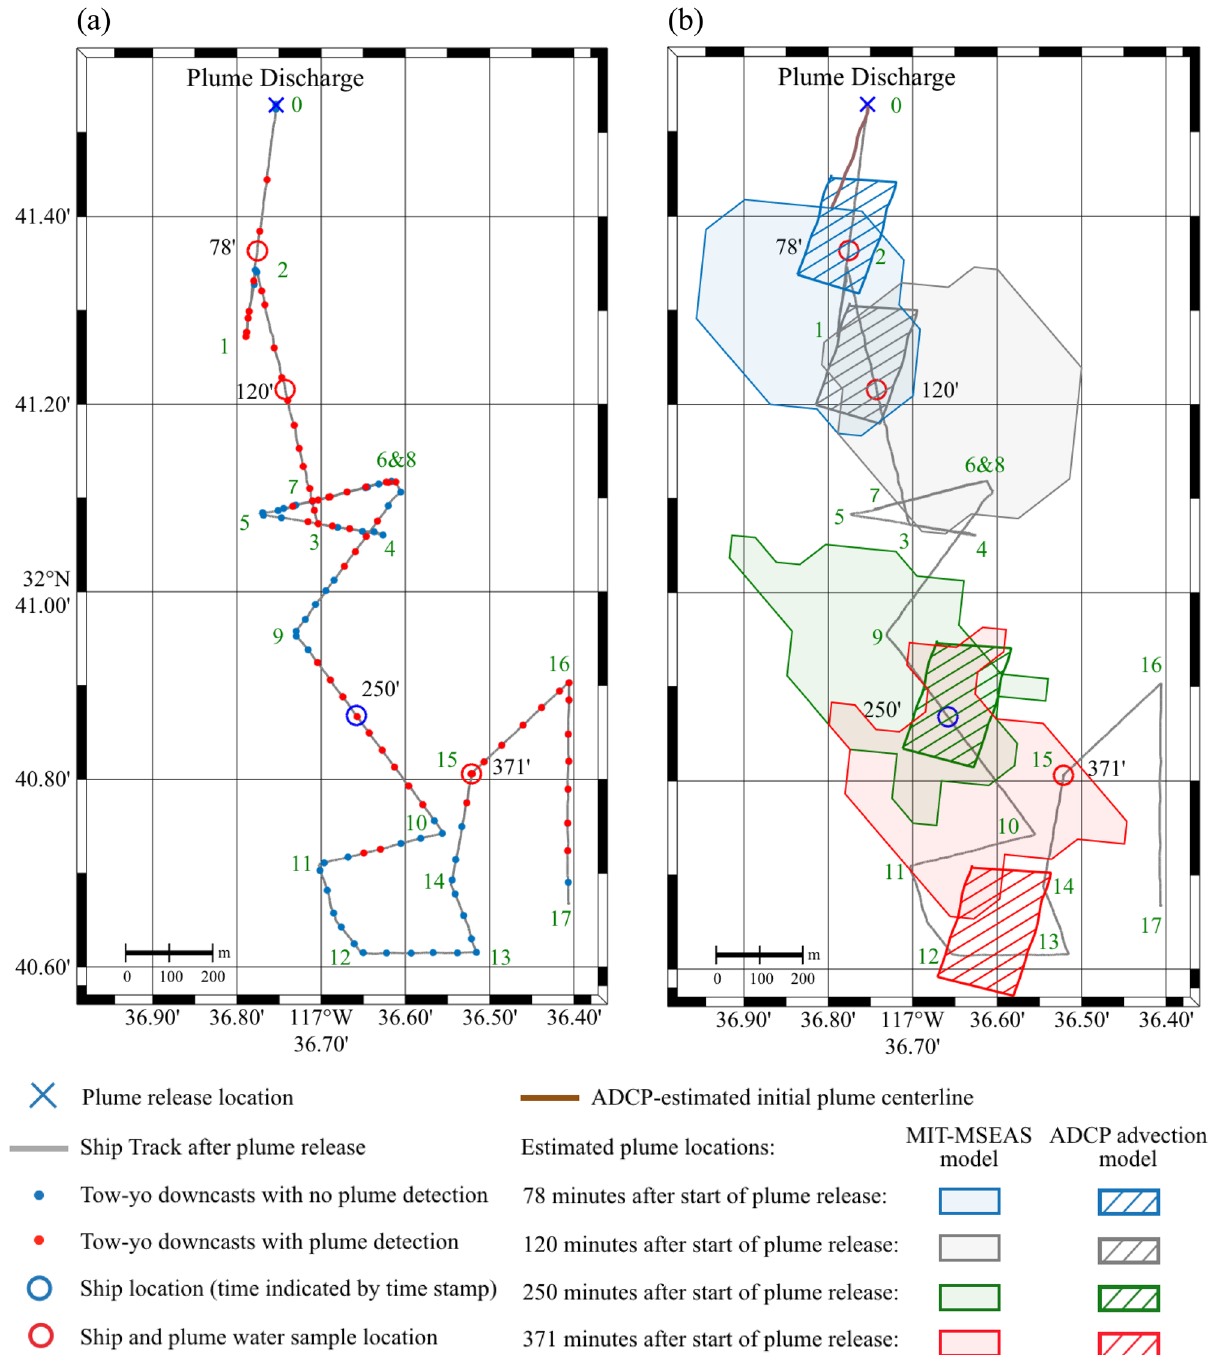
Fig. 4 CCFZ sediment ambient plume tracking. a The dynamic plume was released over 45 min at the location marked by the blue cross producing an ambient plume. The grey line represents the ship track during the tow-yo sampling. The dots on top of the ship track are the start locations of the tow-yo downcasts with (red) and without (blue) ambient plume detections. The open circles (blue and red) correspond to ship position (and ambient plume observations) at the indicated time in minutes from the start of the plume release. The red circles indicate where water samples were taken for the results presented in Fig. 6b – d. The numbers 0 – 17 in green indicate the start of the R/V transects (i.e., transect 0 starts at label 0 and goes to label 1) and correspond to the numbers indicated on top of Fig. 5a, b. b The ambient plume location estimated using the ADCP advection model (hatched patches) and forecast by the MIT-MSEAS model (shaded patches) 78 (blue), 120 (grey), 250 (green), and 371 (red) minutes after the start of the plume release (see “ MIT-MSEAS numerical model ” section). The brown line next to the release location corresponds to the initial centerline (streakline) of the ambient plume, obtained with the ADCP advection model. The width of the ADCP advection model plume is based on the initial tow-yo observations (~120 m), plus the consideration of a lateral effective diffusivity of 0.1 m 2 s − 1 (since the ADCP advection model can only estimate the location of the ambient plume ’ s